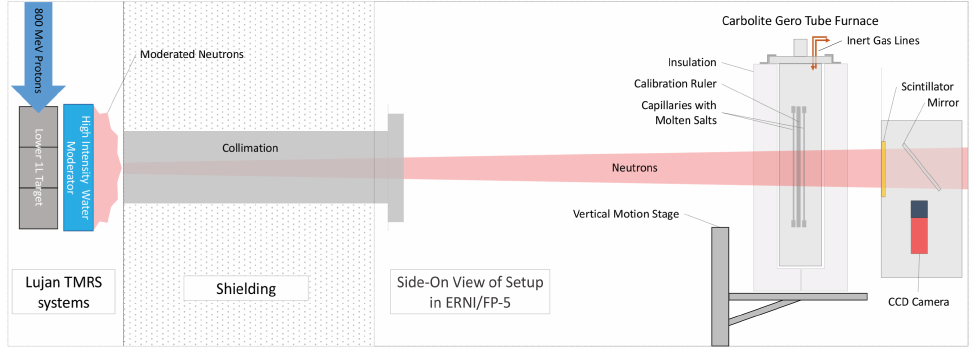
Figure 1. Diagram illustrating a side-on view of the remote density setup on FP-5 at Los Alamos Neutron Science Center (LANSCE) used to measure densities of several molten salts samples at elevated